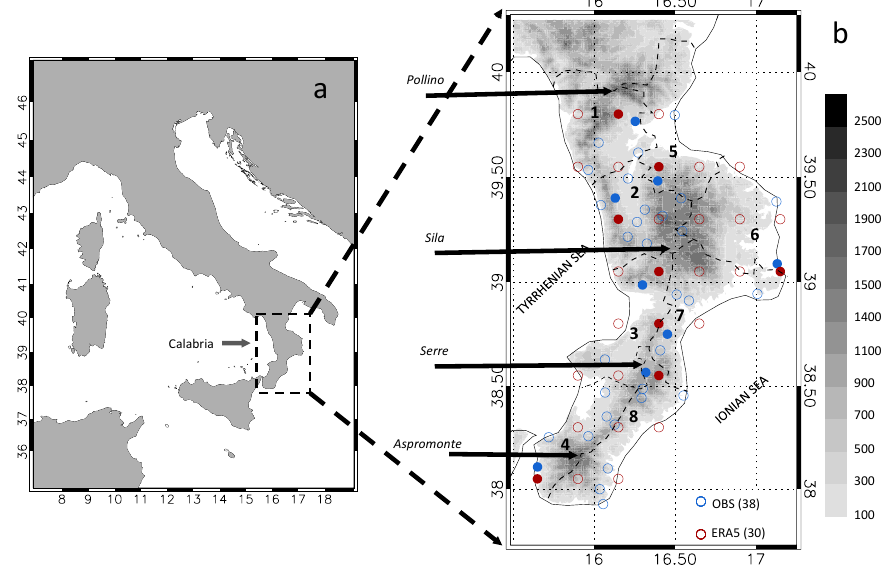
Figure 1. ( a ) Map of Italian peninsula; ( b ) spatial distribution of observations and reanalysis for the Calabria region: observation points (38; blue circles) and ERA5 points (30; red circles). Filled circles indicate the selected points for each zone. The black numbers indicate the eight climatic zones (delimited by dotted contours). The orography of the regions and some locations cited in the text are also